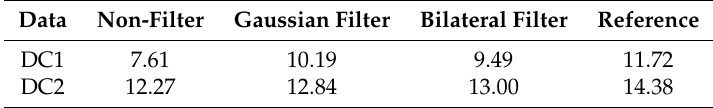
Table 4. Performance of different methods to construct W for noise level 20 dB.